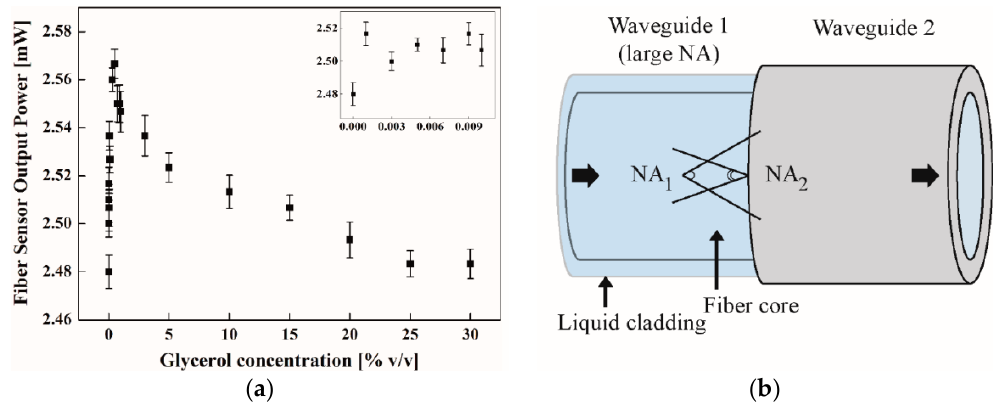
Figure 6. ( a ) Fiber sensor output power with varying concentrations of glycerol (0 to 30% v / v ). ( b ) The interface of the two waveguide domains and the numerical aperture (NA) mismatch between the two.